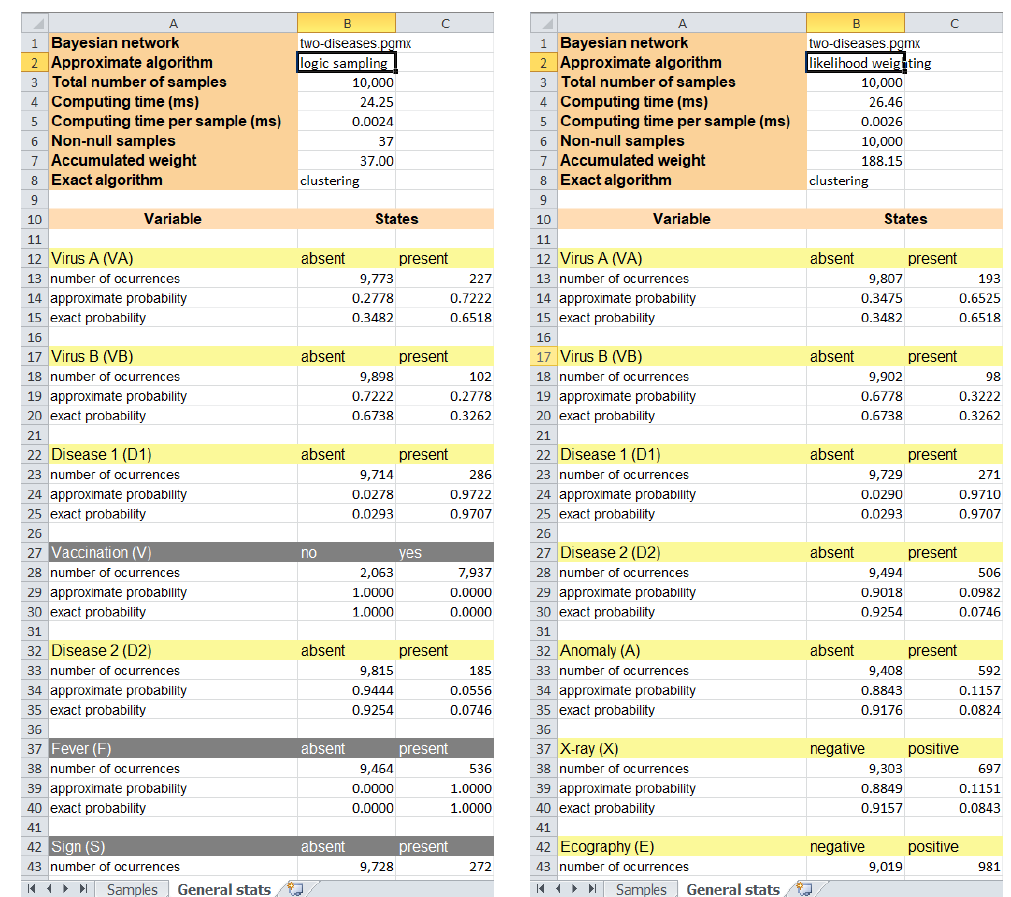
Figure 3. Output of two stochastic algorithms: logic sampling ( left ) and likelihood weighting ( right ), for the evidence { + f ,+ s ,¬ v } . The latter only samples the variables that are not part of the